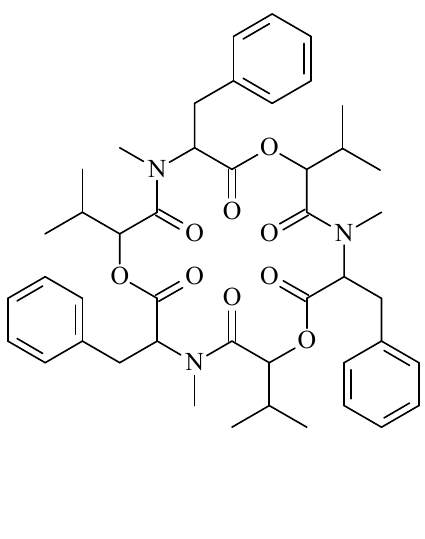
Figure 1. Beauvericin